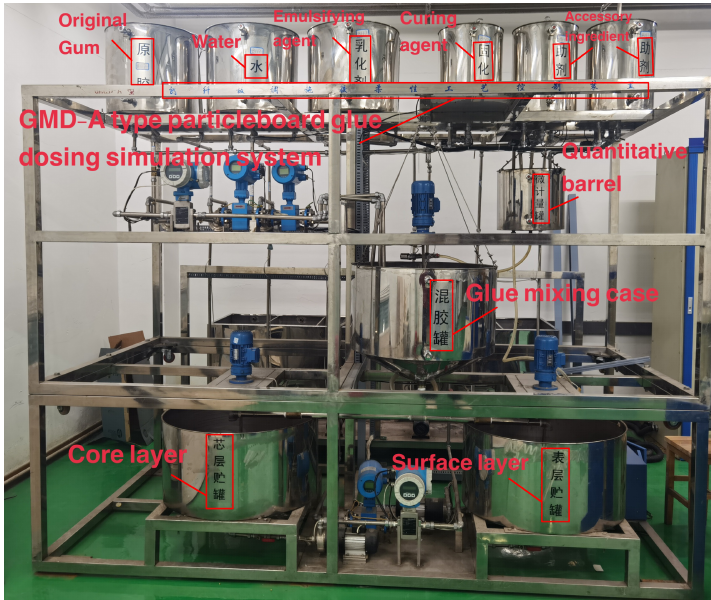
Figure 3. GMD-A -type particleboard glue-dosing simulation system.